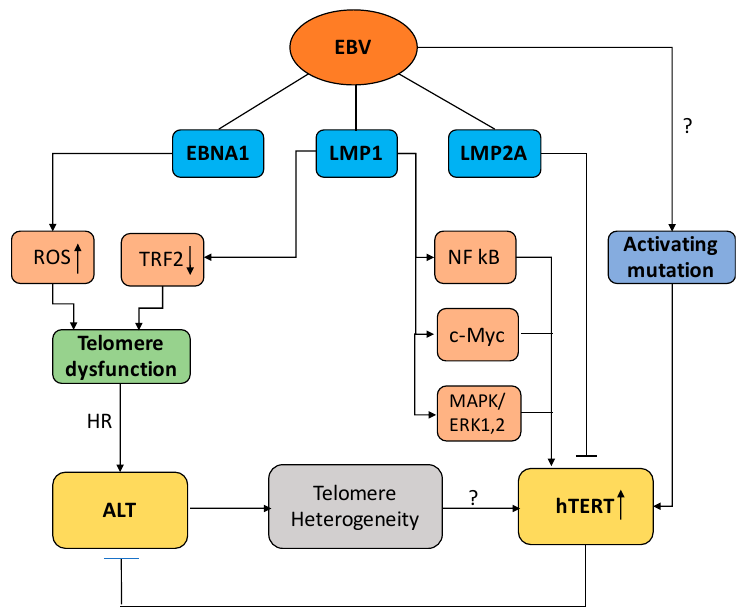
Figure 5. Cartoon illustrating different pathways of viral interference with telomere maintenance during EBV-induced B-cell immortalization. Latent membrane protein 1 (LMP1) promotes the activation of telomerase through several pathways that regulate the transcription and nuclear translocation of human telomerase reverse transcriptase (hTERT), whereas LMP2A inhibits telomerase activity by transcriptional repression of hTERT. Activating mutation in the promoter region of hTERT may contribute to the capacity of EBV to regulate the activity of telomerase. EBNA1 and LMP1 promote telomere dysfunction by inducing oxidative stress and downregulation of TRF2, respectively. Telomere dysfunction in the absence of telomerase activity activates ALT in which telomeres homeostasis is maintained by HR, which results in telomere length heterogeneity. The generation of few extremely short telomeres may, together with the occurrence of activating mutations, contribute to the activation of telomerase.